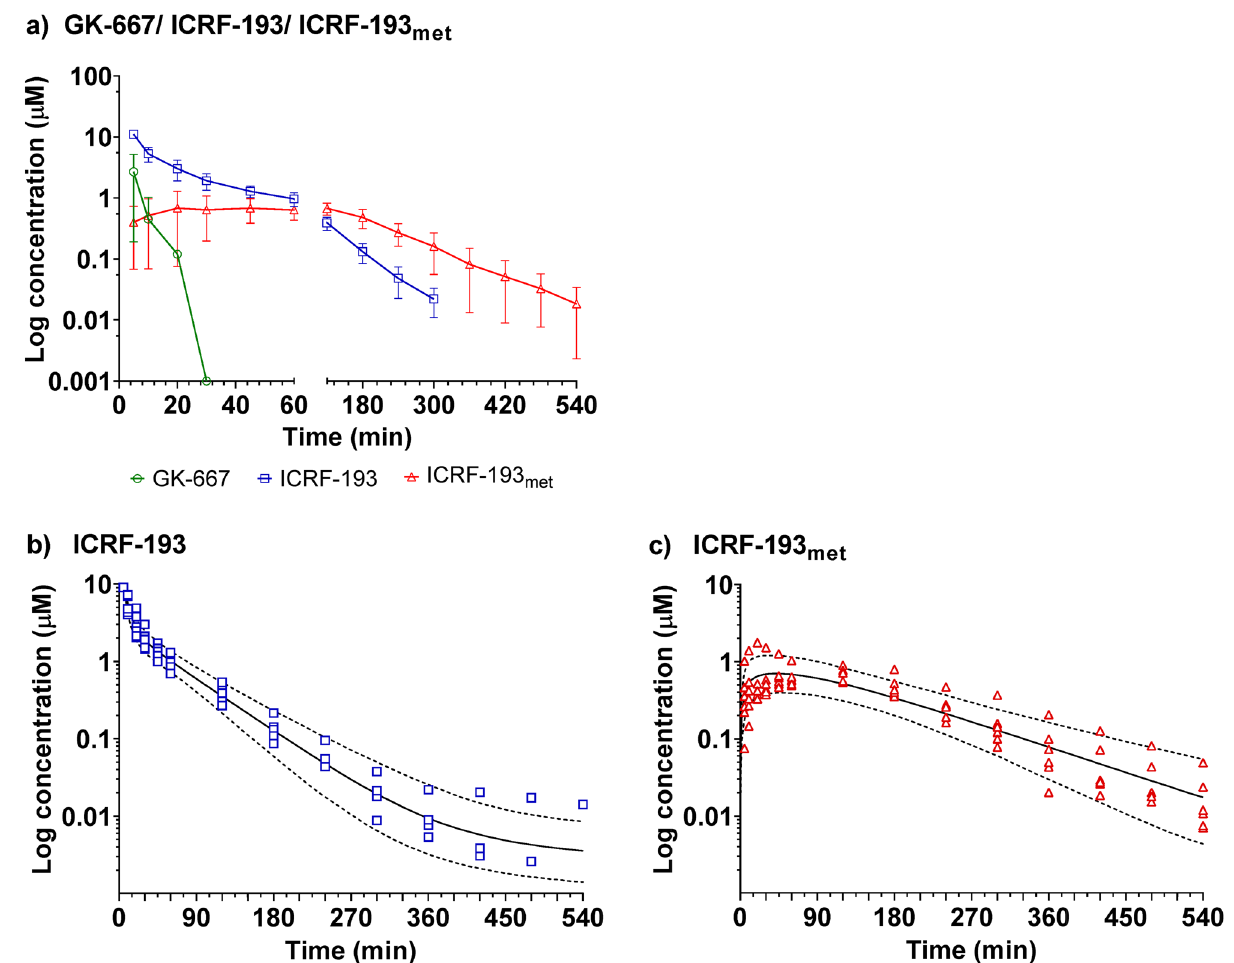
Figure 6. Plasma concentration profiles of the prodrug, ICRF-193 and ICRF-193 met after intravenous administration of GK-667 to rabbits. ( a ) Concentration time profiles of all compounds in plasma obtained after administration of GK-667 (5 mg/kg, i.v. ) to rabbits (n = 6). Goodness-of-fit graphs of the population model of ( b ) ICRF-193 and ( c ) ICRF-193 met . The solid and dashed lines represent the predicted median plasma concentrations and the 90% prediction